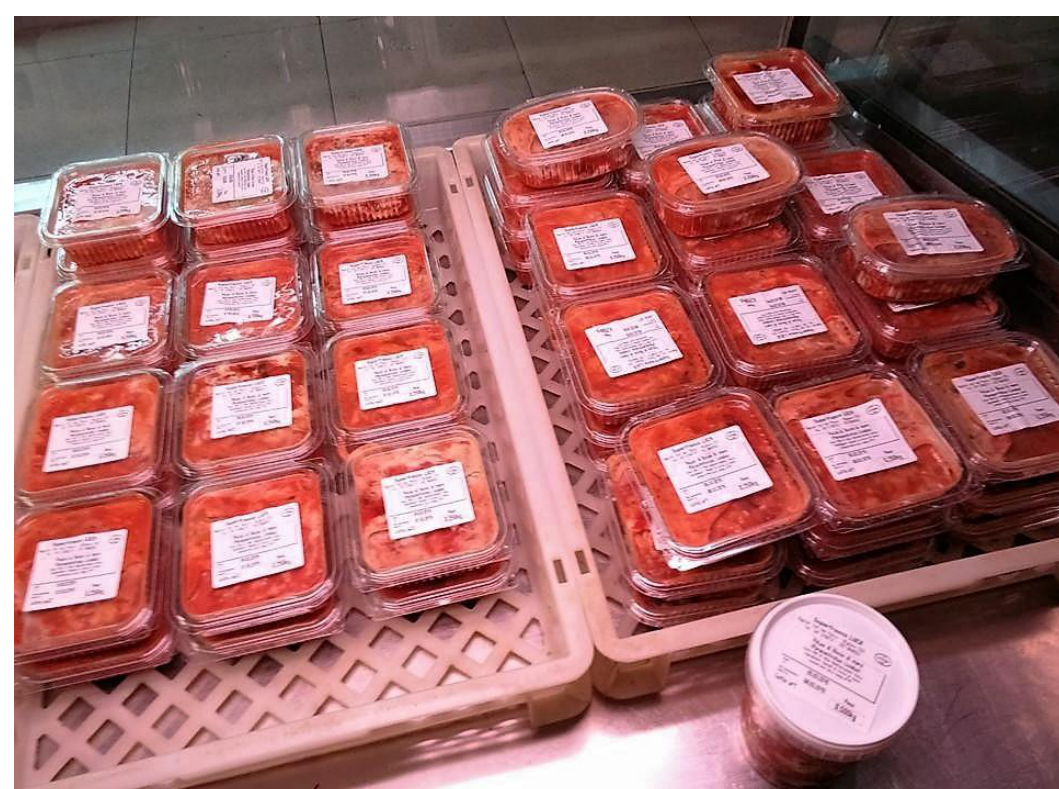
Figure 2. Sea urchin roe ready to be marketed.